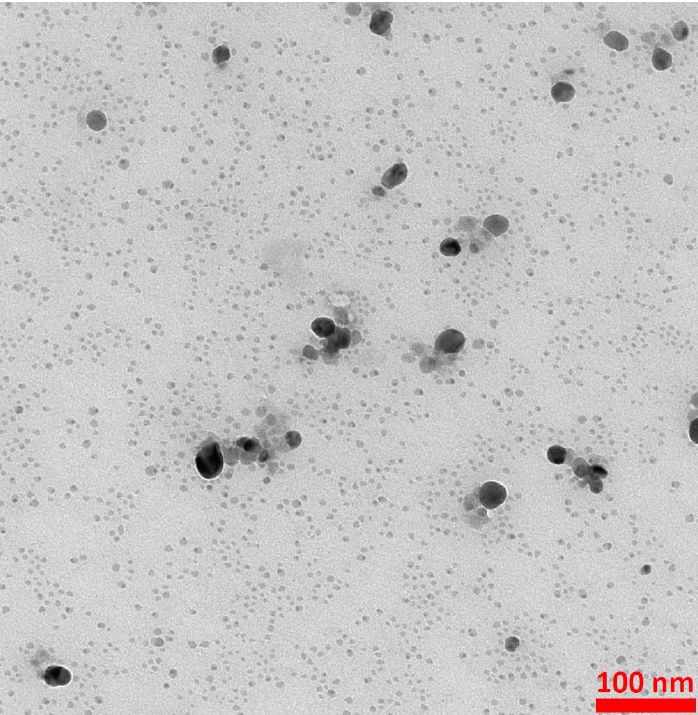
Figure 10. Example TEM image of the formed Ag nanoparticles. The accelerating voltage of TEM microscope: 200 kV. The nanoparticles were deposited using a simple wet deposition method onto 400-mesh copper grid covered with a carbon film.